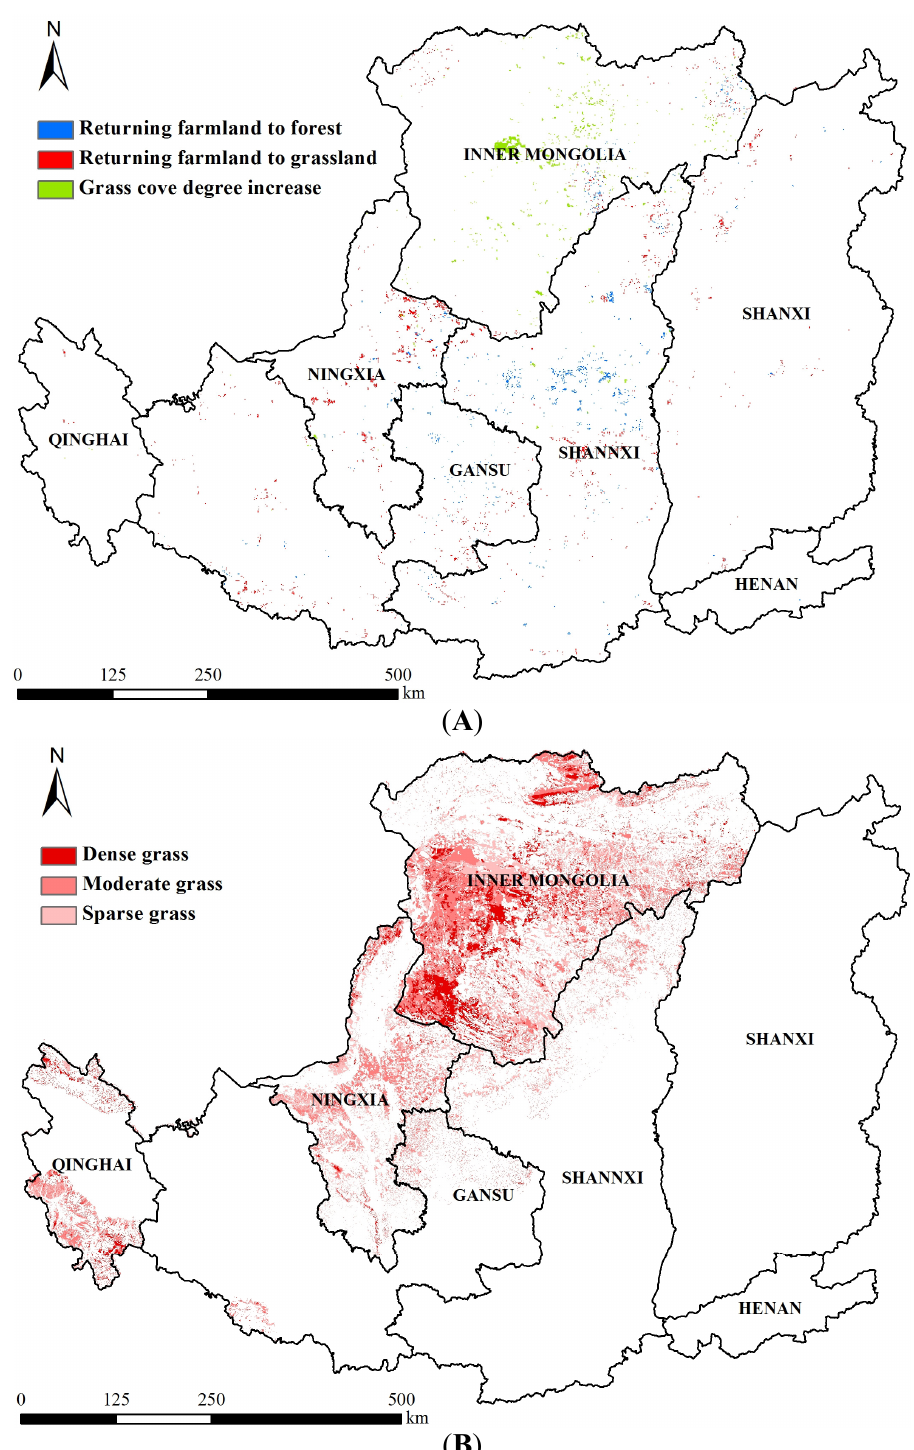
Figure 4. Spatial distributions of three types of land use change ( A ), and three degrees (dense, moderate and sparse coverage) of grassland ( B ) across the Loess Plateau from 2000 to